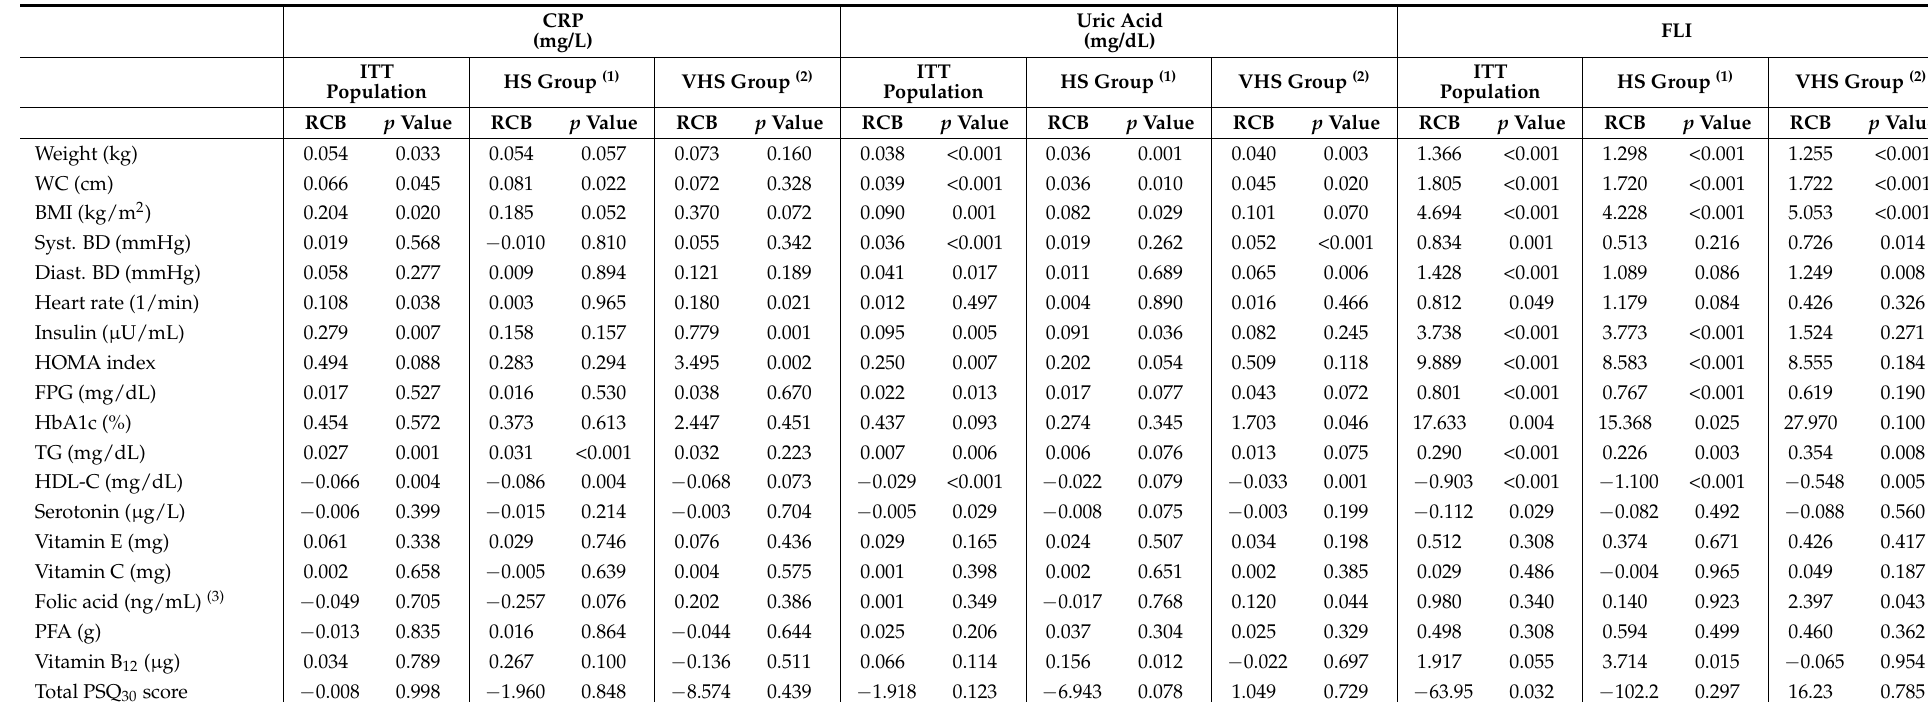
Table 3. Relationship of cardiometabolic risk parameters and in-/direct markers of inflammation and oxidative stress (age